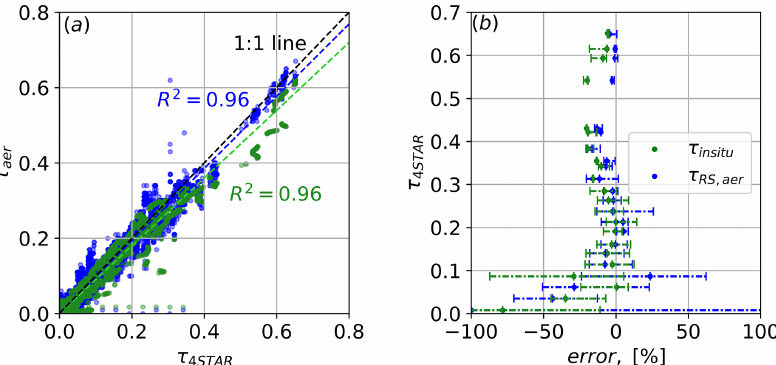
Figure 6. Aggregated τ aer statistics using τ 4STAR as a baseline for the ORACLES campaign. (a) Scatterplots of τ 4STAR vs. τ RS,aer and τ insitu . Regression or τ RS,aer gives R 2 = 0 . 96, slope = 0 . 96, and intercept = 1 . 4 × 10 − 3 , and RMSE is 3 . 0 × 10 − 2 . Regression for τ insitu yields R 2 = 0 . 96, slope = 0 . 90, and intercept = − 2 . 1 × 10 − 4 , and RMSE is 3 . 3 × 10 − 2 . (b) Percent error in τ RS,aer and τ insitu relative to τ 4STAR ; τ 4STAR values are sorted into bins with 0.025 optical depth width, and the corresponding statistics for τ RS,aer and τ insitu are reported. Dots represent the median value; tips of the line are the 25th and 75th quantiles of the τ RS,aer and τ insitu distributions within each bin.